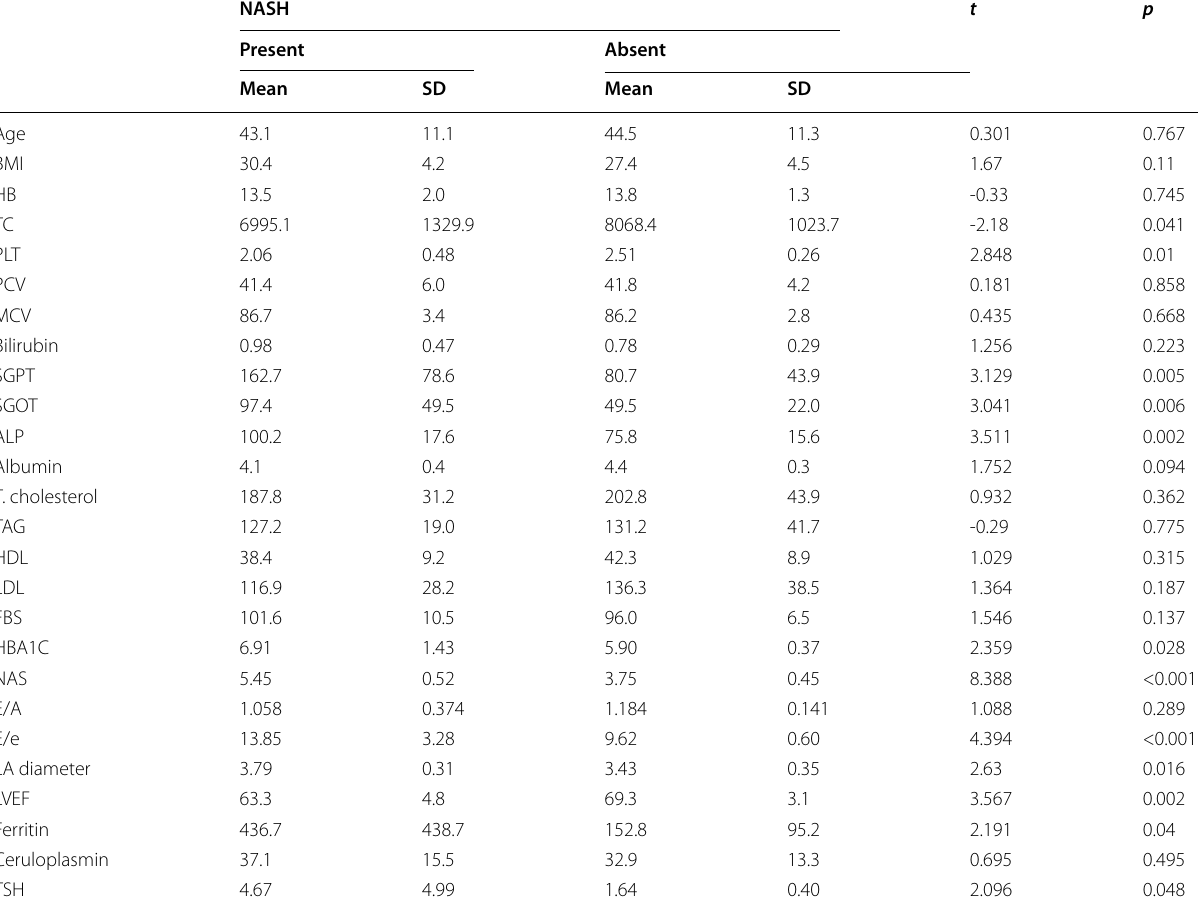
Table 3 Correlation of various variables to diastolic dysfunction NASH t p Present Absent Mean SD